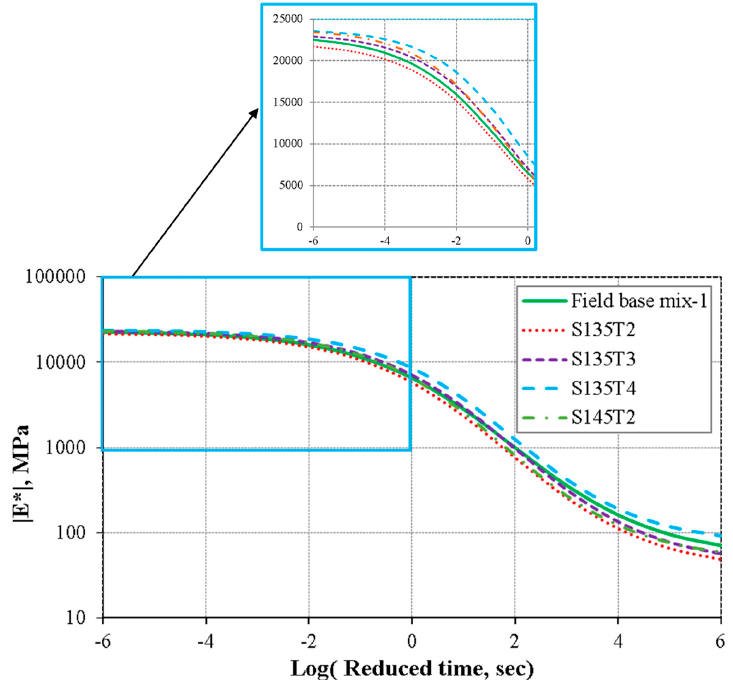
Appl. Sci. 2019 , 9 , x FOR PEER REVIEW Figure 7. Comparison of master curves for base layer mixture from the site (mixture 1). Table 4. Comparison of dynamic modulus results on mixture 2.